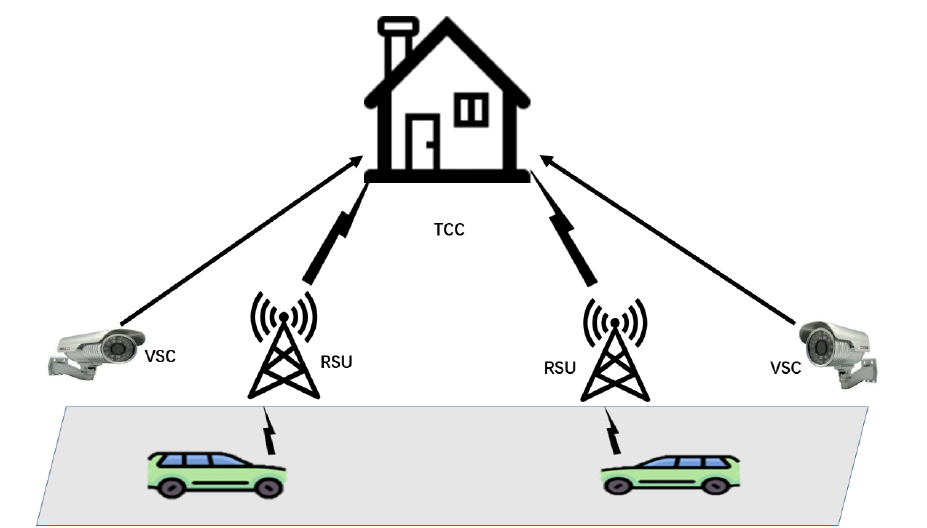
Figure 1. The system model for